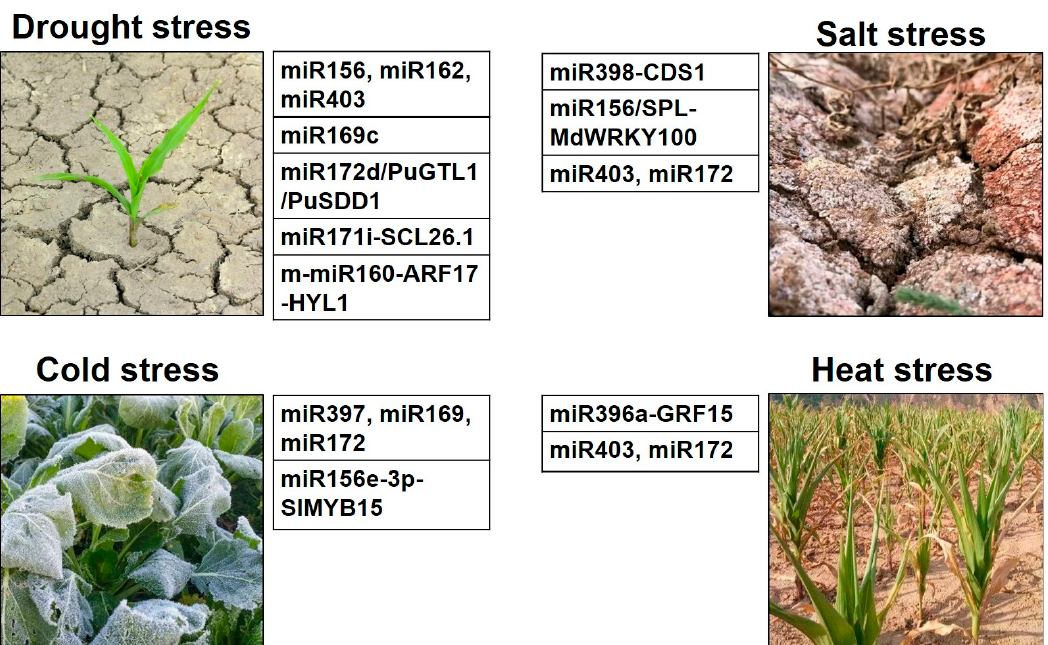
Figure 3. Summary of the miRNAs and their target families related to drought stress, salt stress, cold stress, and heat stress.